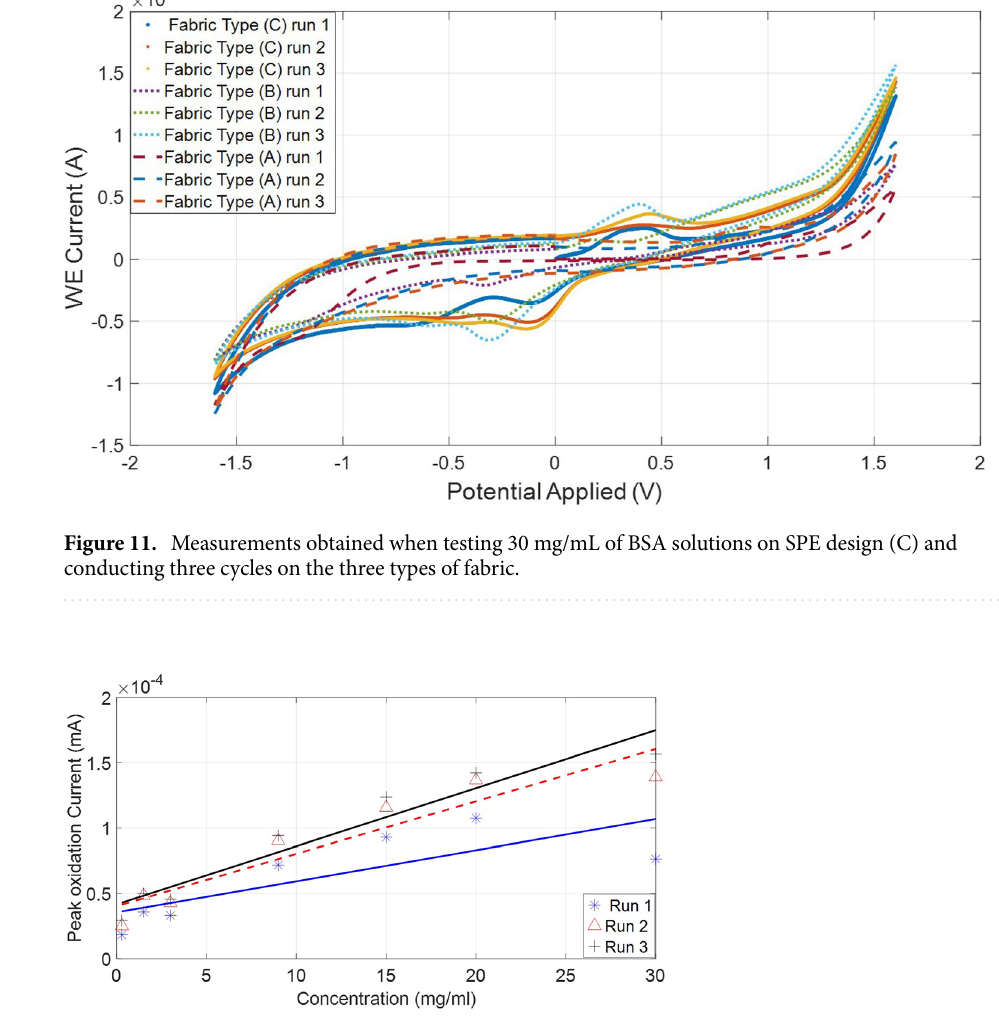
Figure 12. Measurements obtained when testing 8 BSA concentrations on SPE design (C) and conducting 3 cycles for each sample on each